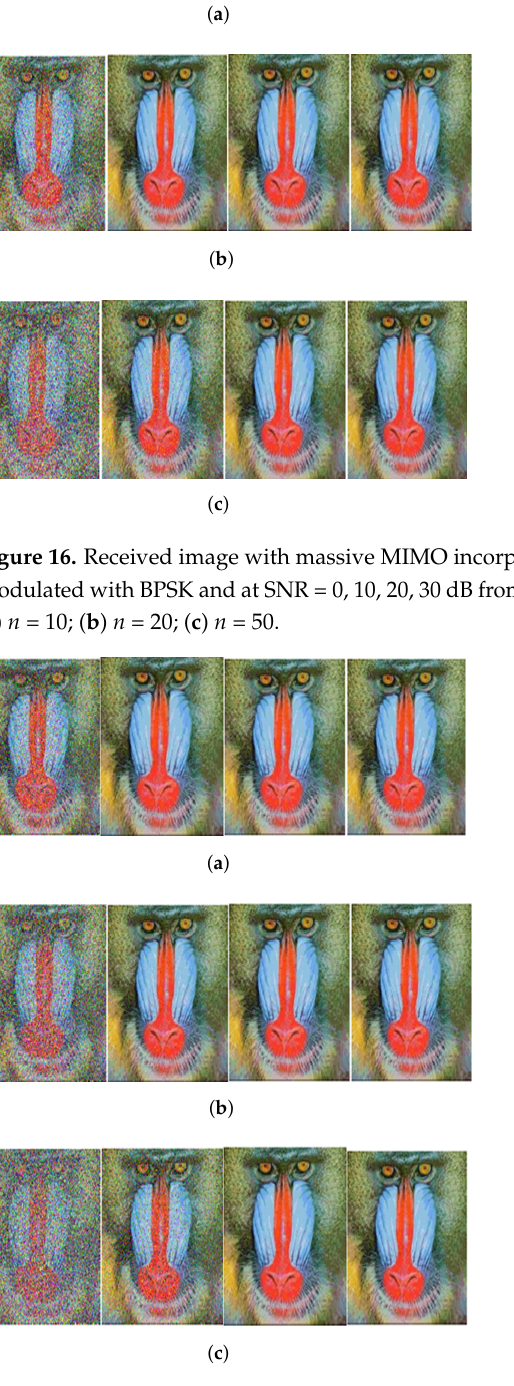
Figure 17. Received image with massive MIMO incorporated DWT-OFDM over a Rayleigh channel, Modulated with QPSK and at SNR = 0, 10, 20, 30 dB from Left to Right for different number of users, n . ( a ) n = 10; ( b ) n = 20; ( c ) n =